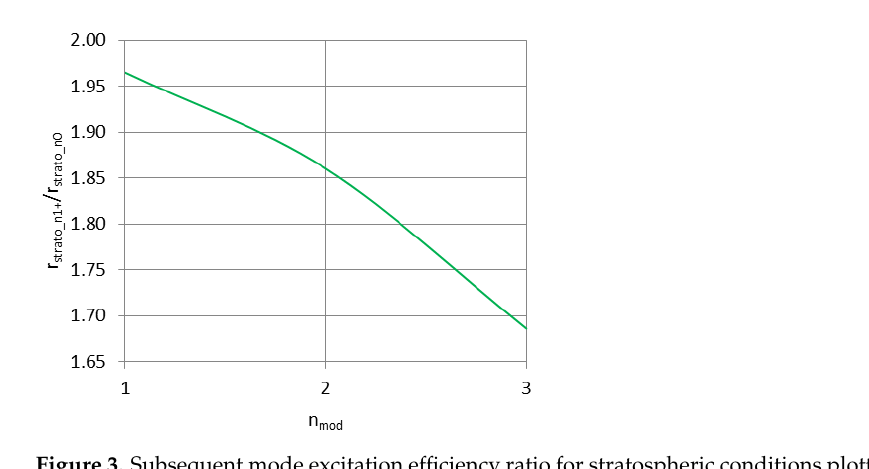
Figure 2. The stratospheric-to-ground mode excitation efficiency ratio plotted for different altitudes.